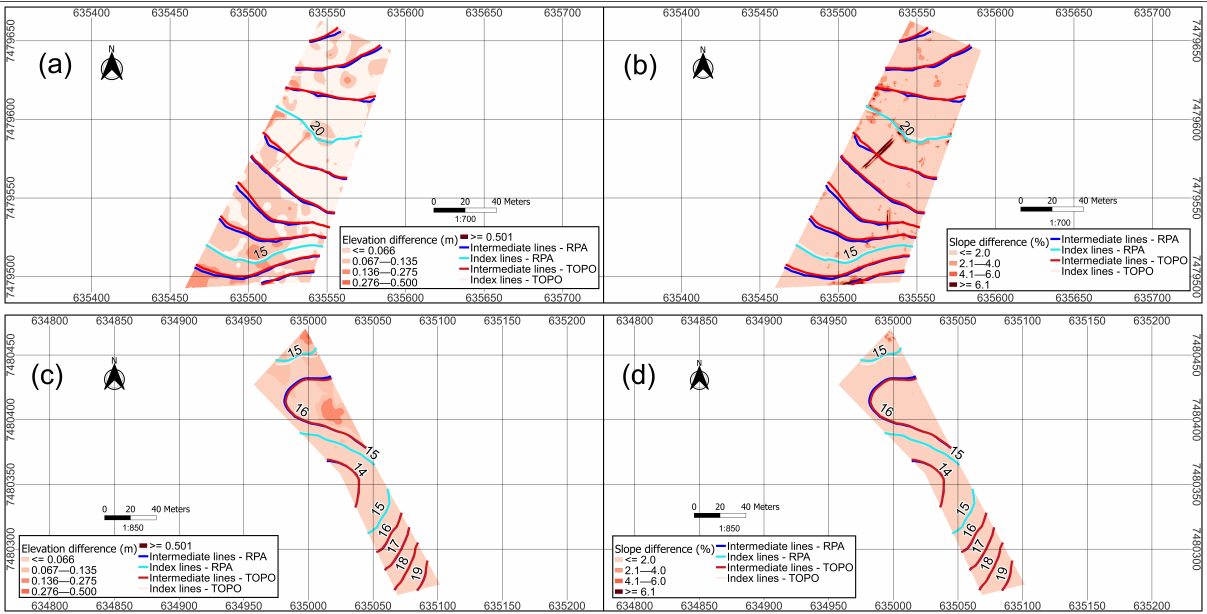
Figure 16. Superposition of homologous contour lines from topography and RPA of areas 1 and 2 over elevation and slope difference maps: ( a ) superposition of contour lines over DEM differences of area 1, ( b ) superposition of contour lines over slope differences of area 1, ( c ) superposition of contour lines over DEM differences of area 2, ( d ) superposition of contour lines over slope differences of area 2.